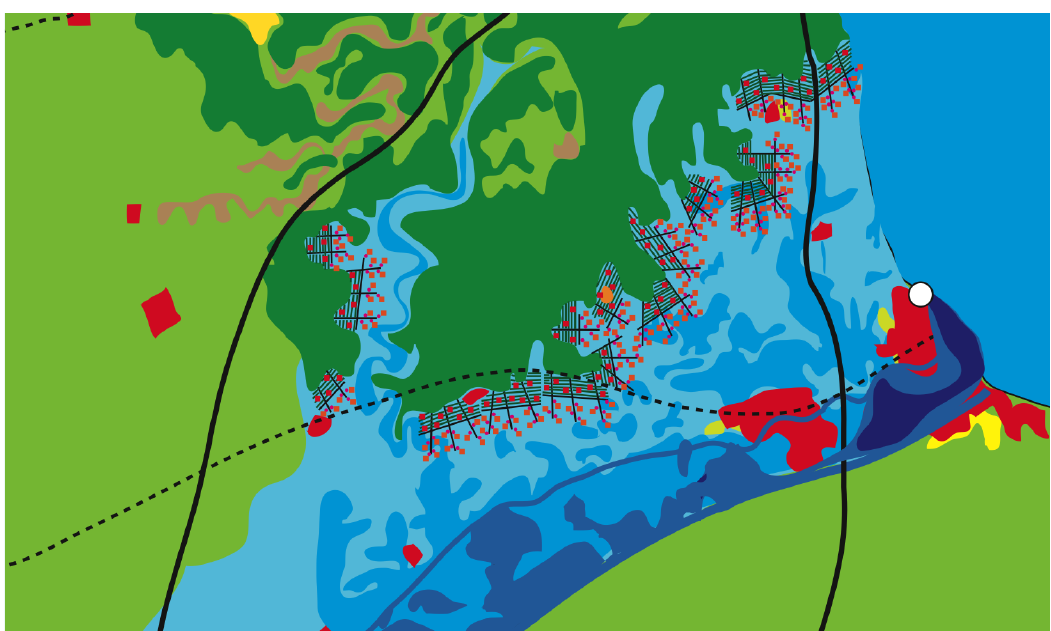
Figure 3. Floodable Eemsdelta (Roggema & Van den Dobbelsteen, 2012). ilar principle as applied in the Sand Engine (Stive et al., 2013), the incoming water enforces the landscape be- hind the dike to adjust and adapt. This delta landscape self-organises its components to make sure the typology of housing and their location is chosen in safe places. Be- cause the water will flow to the lowest point, after the in- let the main direction of how the landscape will evolve is clear. In detail natural processes such as wind speed and direction, the amount and type of sediment, the shape of contour lines are the few guiding principles that deter- mine the exact land forming, the build-up of new soil and where new housing can be developed. The entire zone under influence of the water is redundant and functions as an absorption zone, in which many different develop- ments can be accommodated. The pace of sea level rise is not relevant, as the area is always prepared for any change in sea